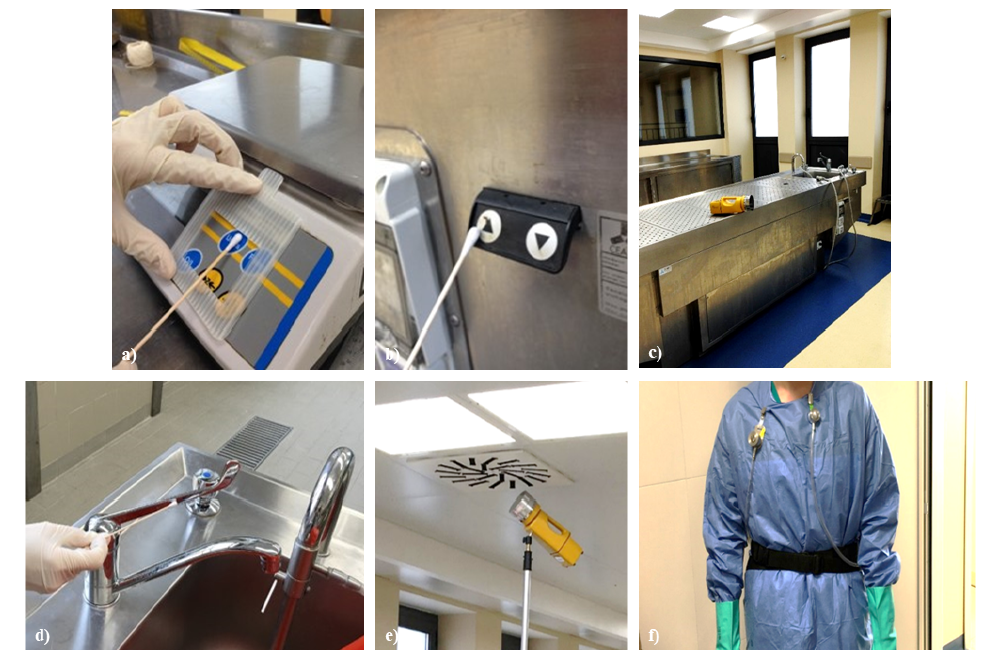
Figure 1. Sampling sites: ( a ) scale keyboard; ( b ) autopsy table button; ( c ) autopsy table; ( d ) tap mixer; ( e ) air intake grids; ( f ) personal sampling by IOM sampler.